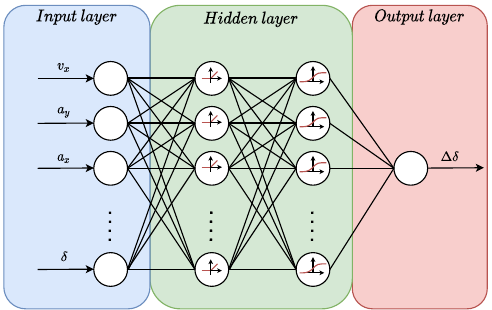
Figure 5. Neural network for the matching